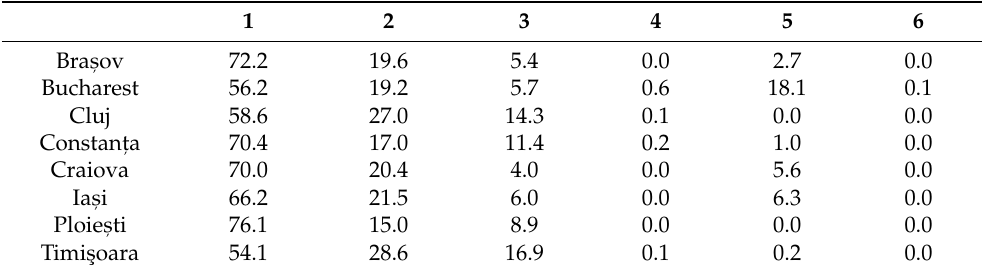
Table 3. The percentage distribution of the LCRPGR classes for the 2000–2014 period. (1—efficient land use, 2—inefficient land use, 3—moving toward efficiency, 4—moving away from efficiency, 5—insufficient land per person, 6—moving toward sufficient land per